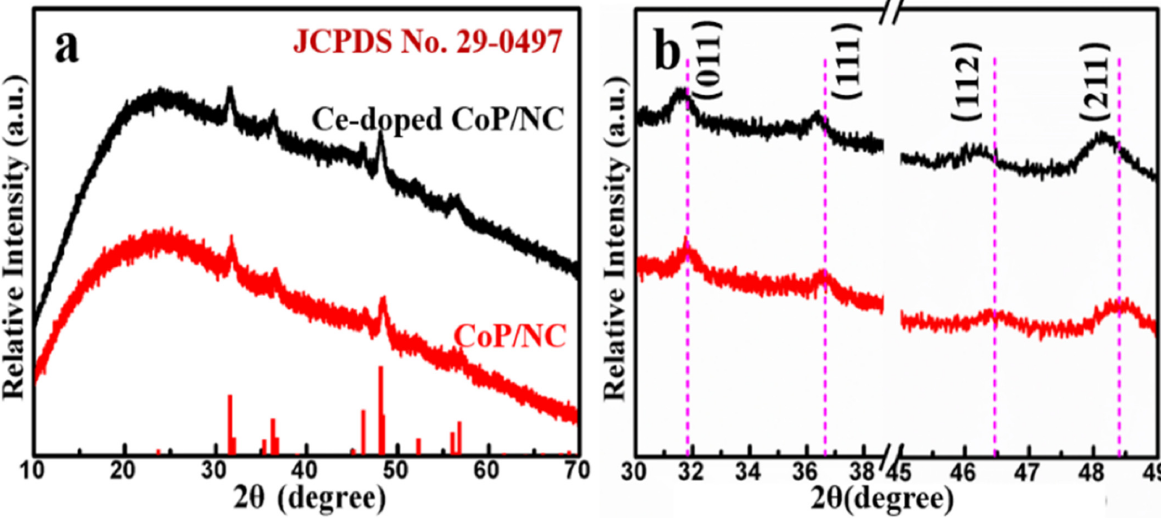
Figure 2. ( a ) XRD patterns, ( b ) the magnified diffraction peaks of the (011), (111), (112), and (211) of Ce-doped CoP@NC and CoP@NC.